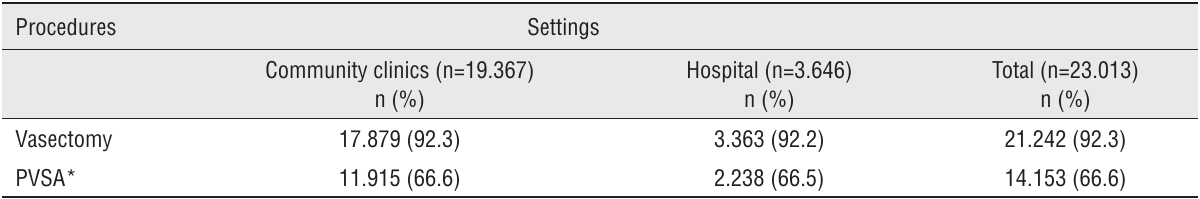
Table 1 - Number of procedures performed in the study cohort of men seeking vasectomy according to clinical settings. Procedures